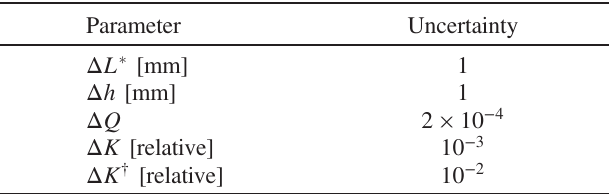
TABLE III. Uncertainties used for estimating error of β (cid:1) measurements. Δ K is the uncertainty in the integrated strength of the modulated quadrupoles, while Δ K † is the uncertainty in the integrated strength of the quadrupole fields from LER present in the HER orbit. The tune uncertainty is for normal turn by turn measurements, while a gated turn by turn measurement for a pilot bunch can be used to get a tune uncertainty of 2 × 10 − 5 . For the other parameters typical values have been assumed. The gated turn by turn tune measurement could improve the accuracy, but was not used for the data presented in this paper.